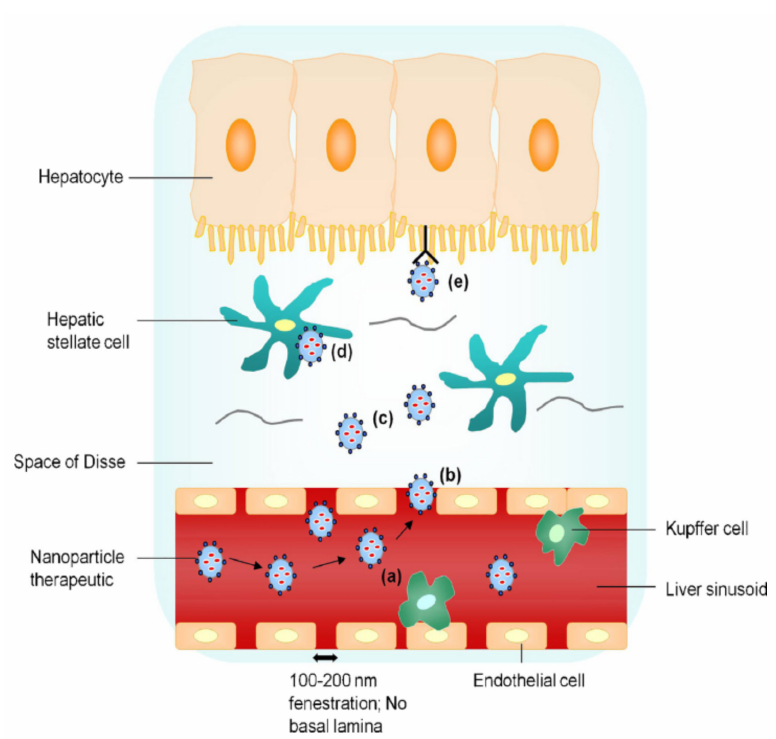
Figure 3. Liver-targeting process of nanoparticle drug delivery system. Reproduced from Nanotoday 2010, 5(4),